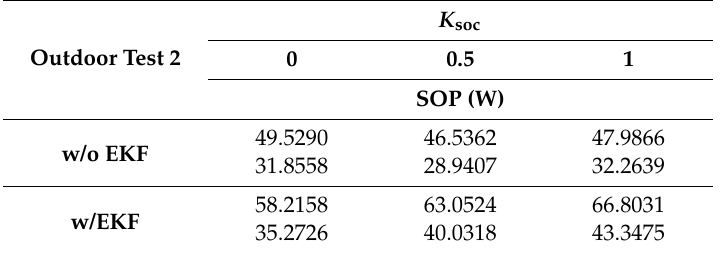
Table 6. Outdoor test result (10 kg